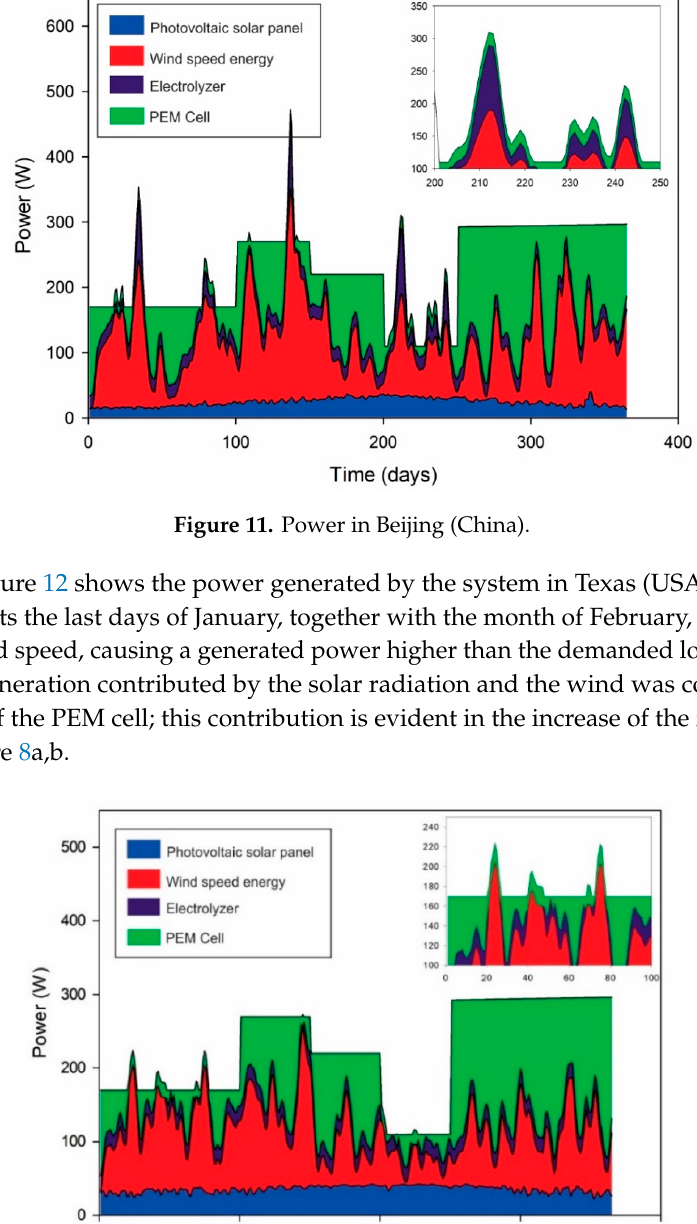
Figure 12. Power in Texas (USA).